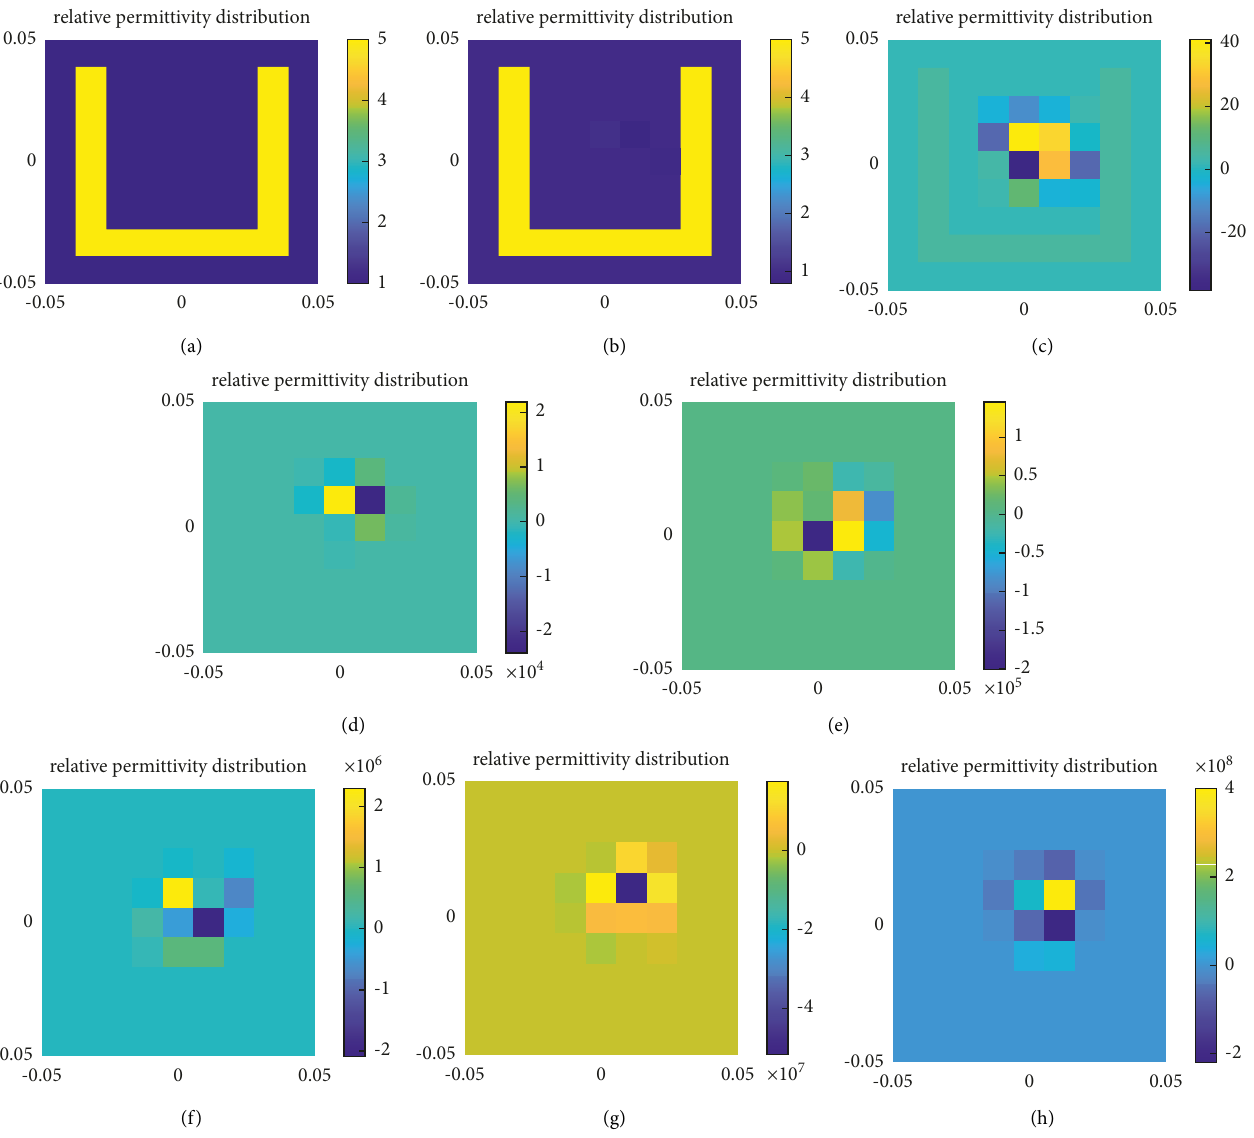
Figure 16: Imaging results with different signal-to-noise ratio. (a) No noise. (b) Snr Snr 60. (g) Snr (cid:31)